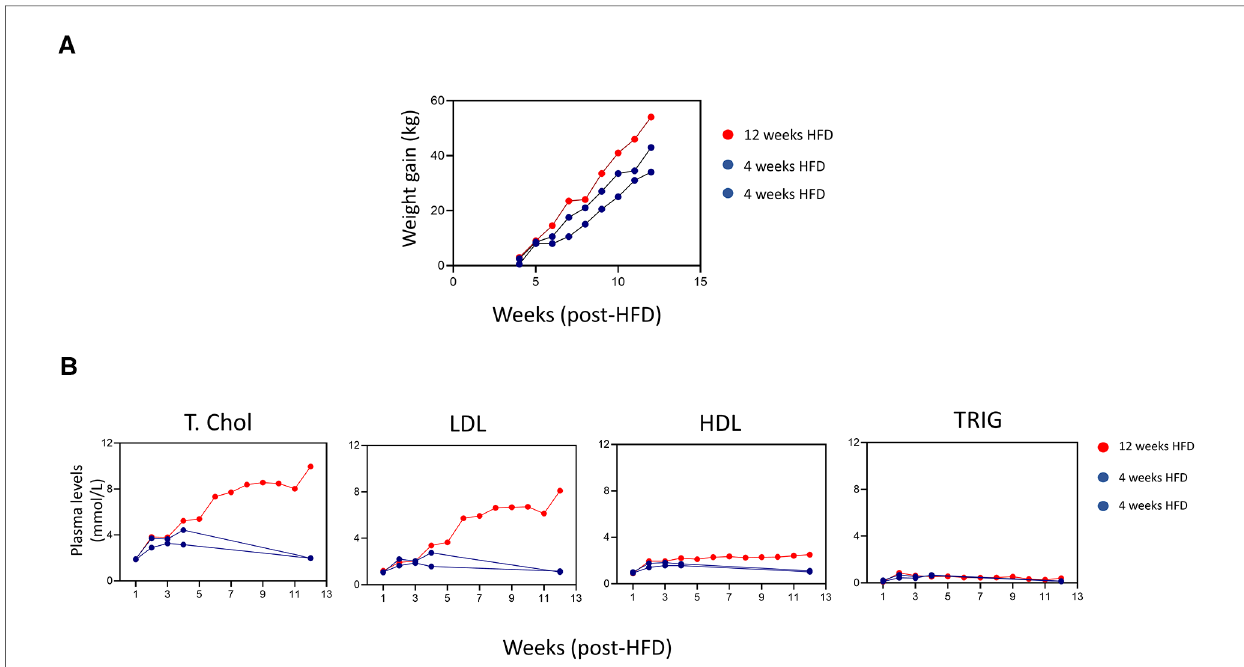
FIGURE 2 Weight gain and increased plasma lipids in response to HFD. ( A ) Graph plots of body weight gain (kg) of individual pigs monitored weekly from the initial weight before surgery. ( B ) The levels of plasma total cholesterol (Total chol), low-density lipoprotein (LDL), high-density lipoprotein (HDL), and triglyceride (TRIG) (mmol) were monitored for individual pigs during 12 weeks